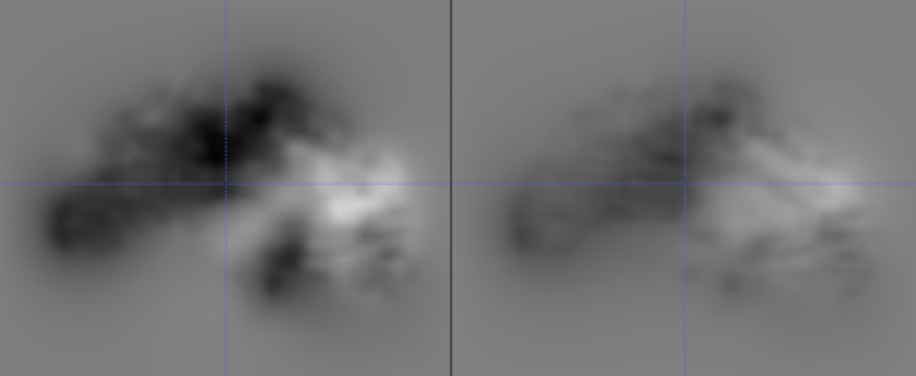
Figure 7. An example of a good reconstruction ( left ), which has much smaller, and more localized deformations compared to an example of a bad reconstruction ( right ), which requires large defor- mations everywhere. Smaller deformations are displayed by the darker intensities, while the larger deformations are displayed by lighter